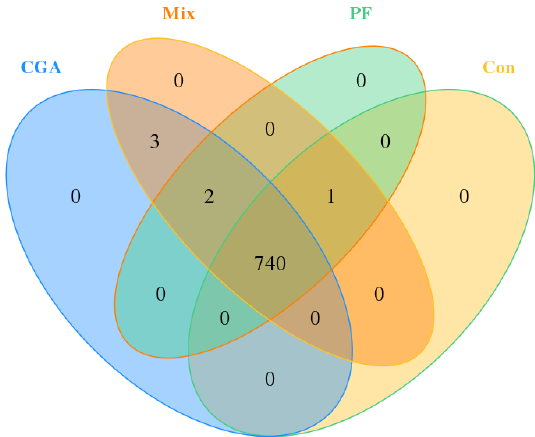
Figure 3. OTU Venn diagram of rectal microbes in finishing pigs. The overlapping numbers between multiple color graphs are the number of features shared between multiple samples, and the non- overlapping part is the number of unique features of each sample.